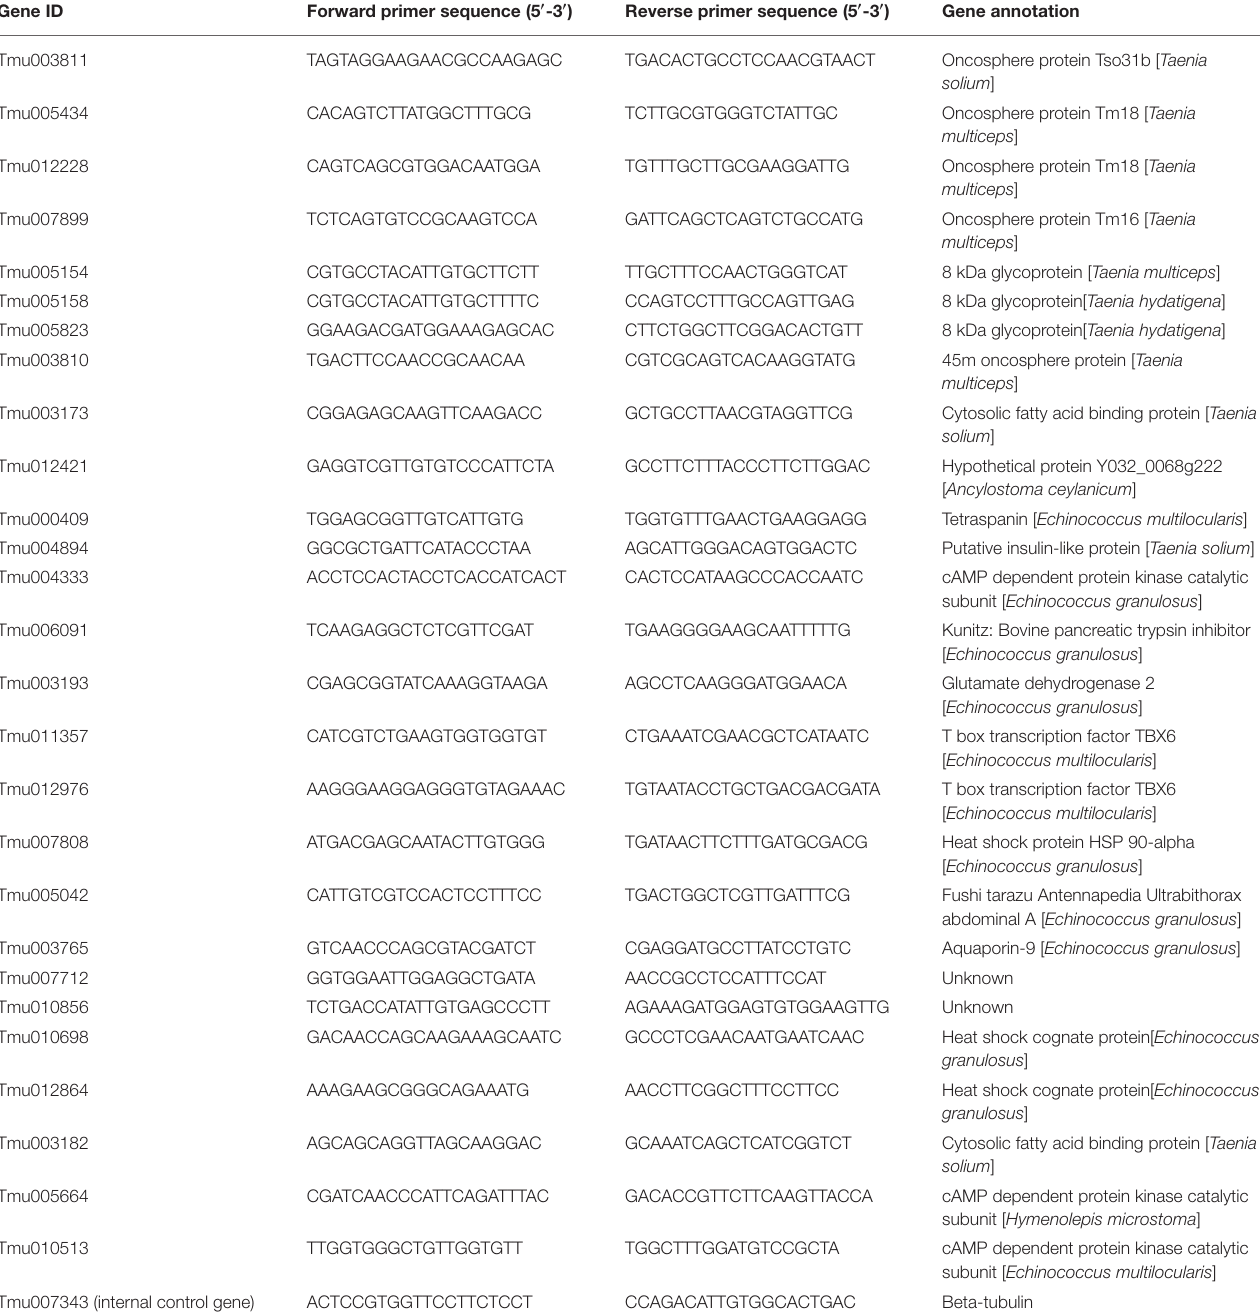
TABLE 1 | qRT-PCR primers of differentially expressed